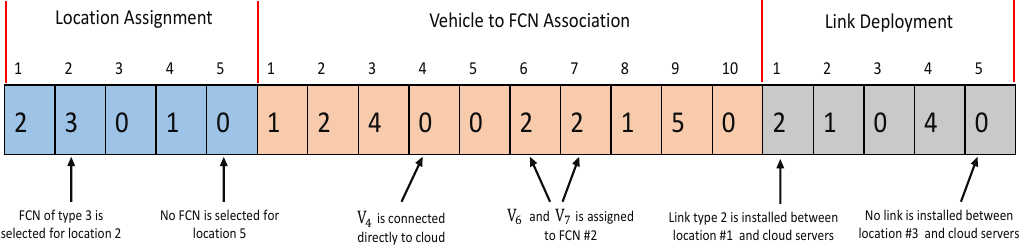
Figure 6. Proposed MCPE-based encoding string for g th